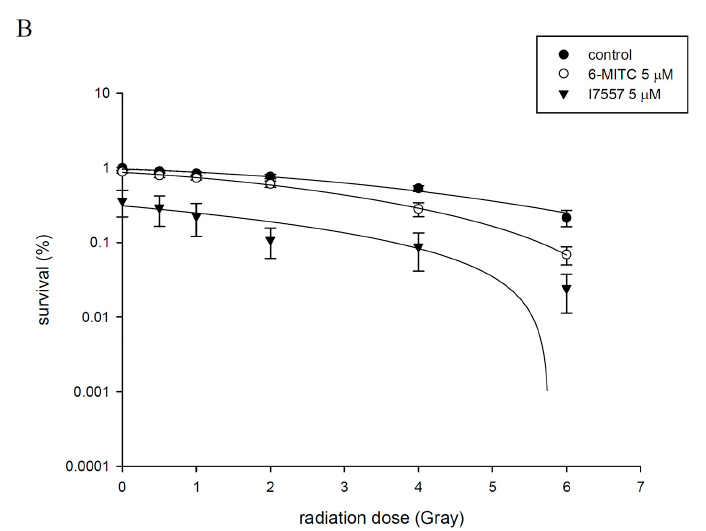
Figure 7. The effect of wasabi compound of 6-MITC and its derivative, I7557, on radiosensitivity of SAS cells. Cells were treated with 5 µM of 6-MITC, I7447, and I7557 for 24 h before irradiation. After irradiation, drugs were washed out, and cells cultured for 8 days in colony formation assay. The survival fraction of radiation, combined with 6-MITC or I7557, was found ( A ). The SER of 6-MITC and I7557 was calculated using a linear-quadratic model ( B ). Results from five separate experiments are expressed as the mean ± SEM.